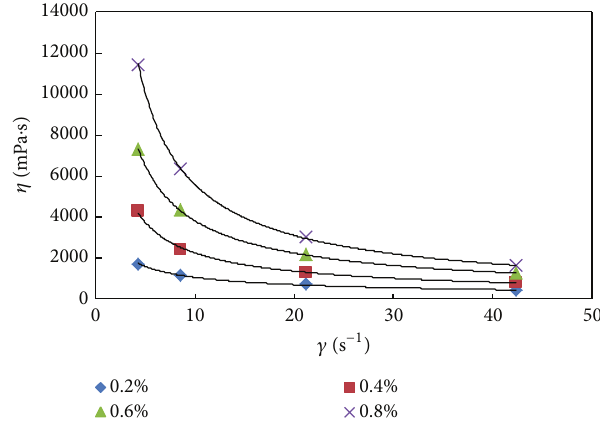
Figure 3: Relationship between apparent viscosity and shear rate of foamed gel.